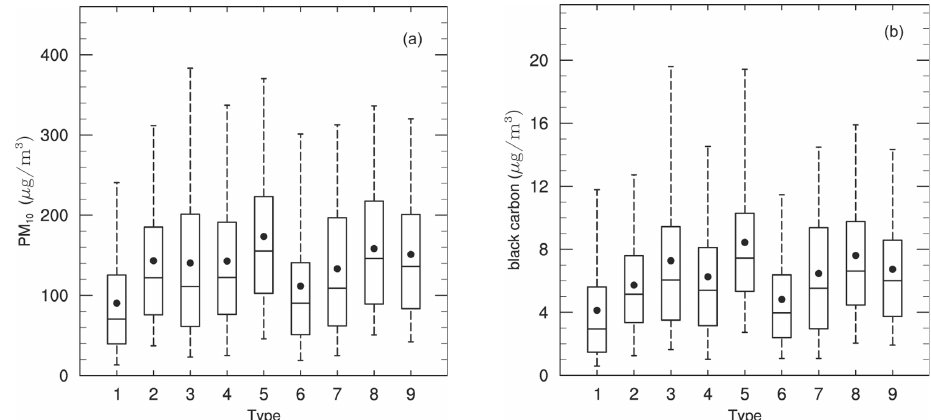
Fig. 9. PM 10 (a) and BC (b) concentrations at the PKU station vs. circulation type during the period 2005 to 2009. Solid dots denote the mean. The horizontal lines across the box show the median and first and third quartiles, while the lower and upper crosses represent the 5th and 95th percentiles,